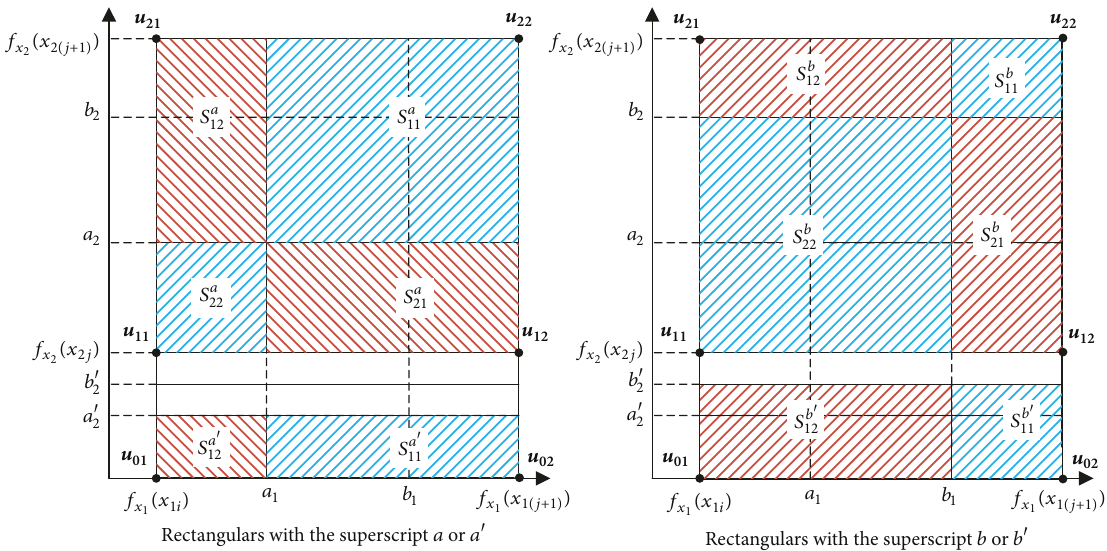
Figure 7: Semantically weighted inter-extrapolative reasoning method on G ( B